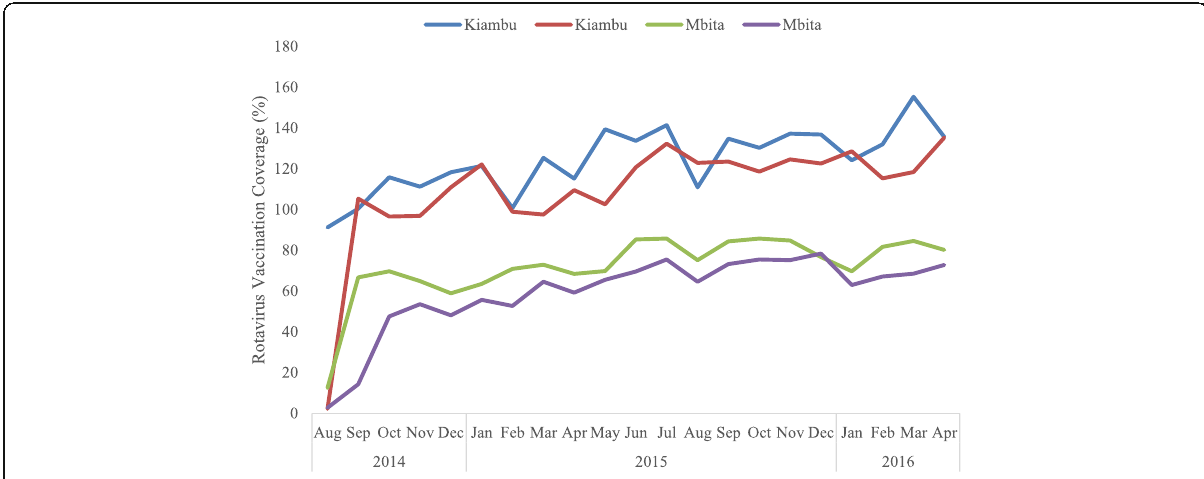
Fig. 1 Trends in monthly rotavirus vaccination coverage in Kiambu and Mbita sub-counties, 2014 – 2016. The graph compares the trends in monthly rotavirus immunization coverage rates between Kiambu and Mbita sub-counties as estimated from the vaccine administrative data for doses 1 and 2 between August 2014 and April 2016. The vaccine administrative data was used with permission from the Kiambu and Mbita sub-counties ’ Units of Vaccines and Immunization Services